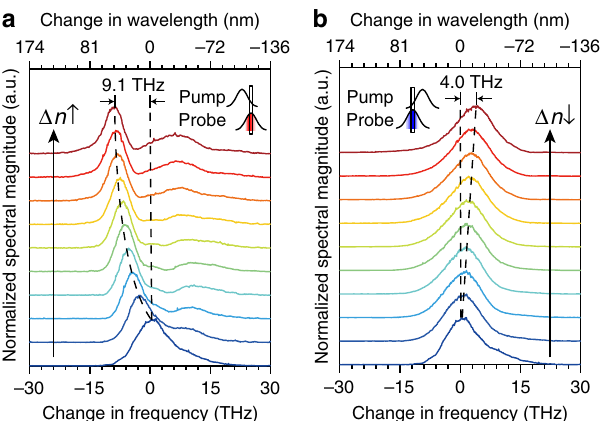
Fig. 2 Pump-induced frequency translation at a fi xed delay time. a – b The frequency of a 1235 nm probe beam redshifts at the delay time t d = − 60 fs in a and blueshifts at the delay time t d = 60 fs in b . The insets show the relative position of the pump and the probe. The top-most (bottom-most) spectra in both panels correspond to the largest (zero) pump intensity and, consequently, the largest (zero) change in the refractive